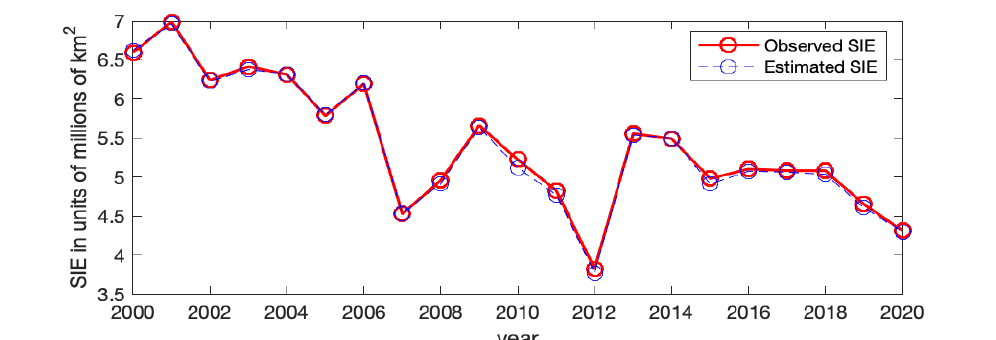
Figure 9. Observed Arctic SIE (red solid line) versus the estimated Arctic SIE based on the model given by (3) (blue dashed